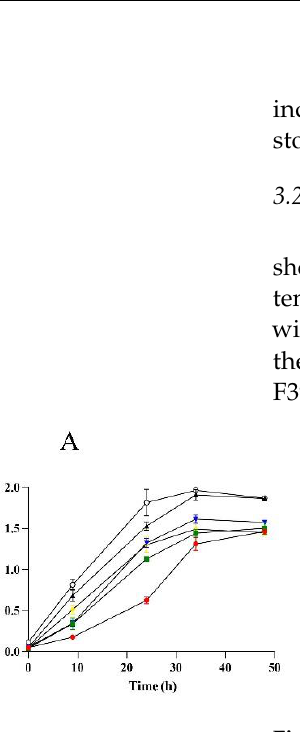
Figure 2. Effect of temperature ( A ), pH ( B ), and different carbon sources ( C ) on F39 growth. OD 600 values were used to present the growth rate of F39.